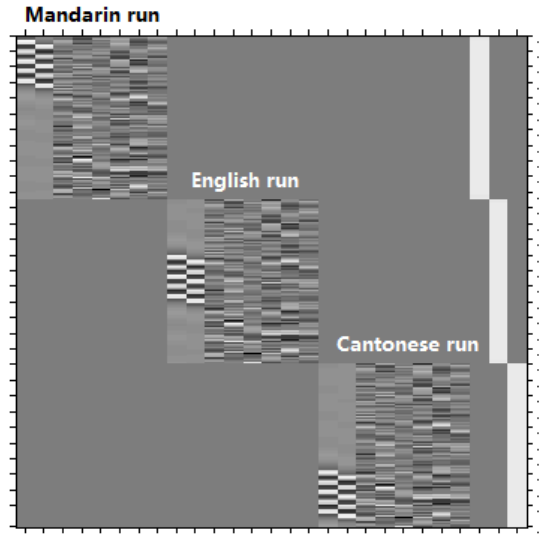
Figure 2. The exact general linear model (GLM) design matrix for activity produced by the visual modality of Cantonese, Mandarin, and English, taking the first subject as an example. There are three language runs, conducted in the order of Mandarin, English and Cantonese. For each language run, there are eight columns. From the left to the right, the first column represents five experimental blocks (the five white strips), and the second column represents five control blocks (the five white strips), and the following six columns represents the six head movement parameters.